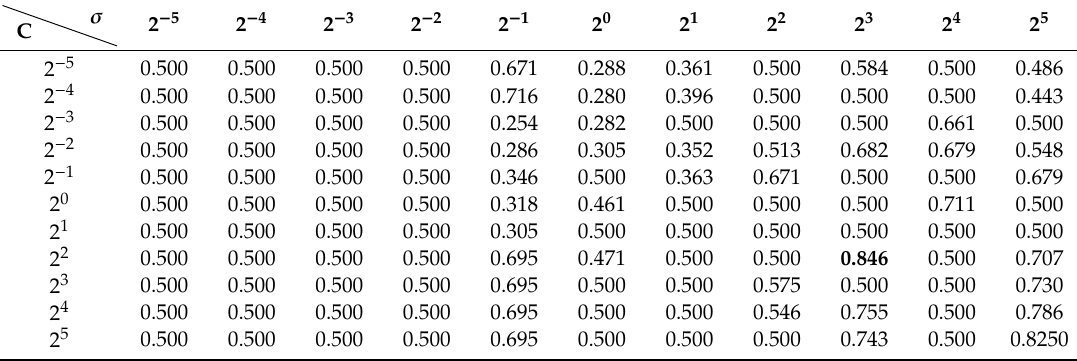
Table 4. SVM grid search results for choosing the optimal